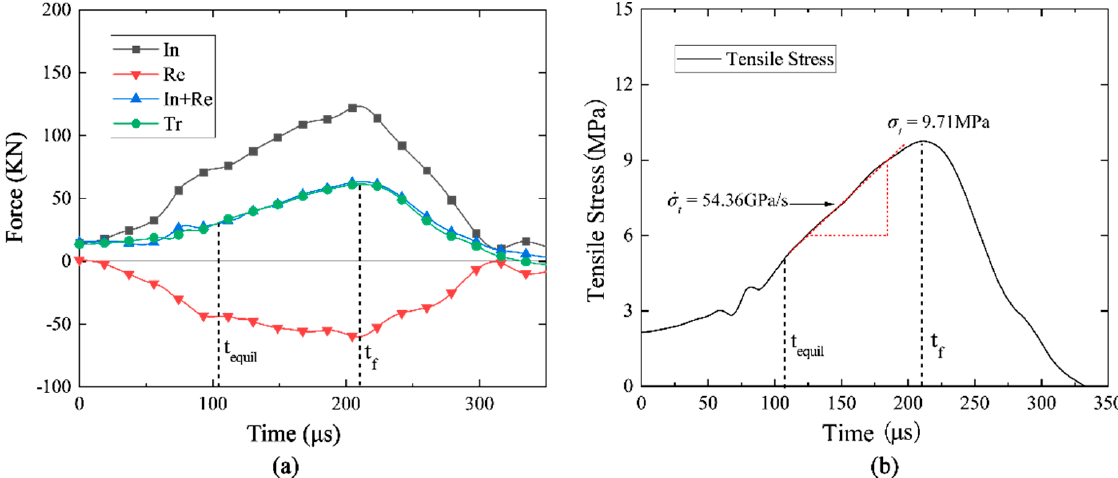
Figure 4. ( a ) Force histories of the bars for specimen SC-1. ( b ) Tensile stress history of specimen SC-1 under coupled static–dynamic loading.